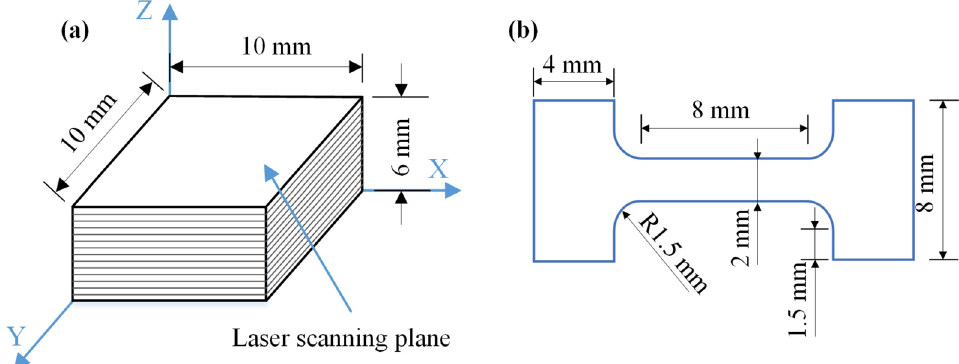
Figure 4 Cubic specimen formed by SLM and size of tensile specimen a Cubic specimen, b Tensile